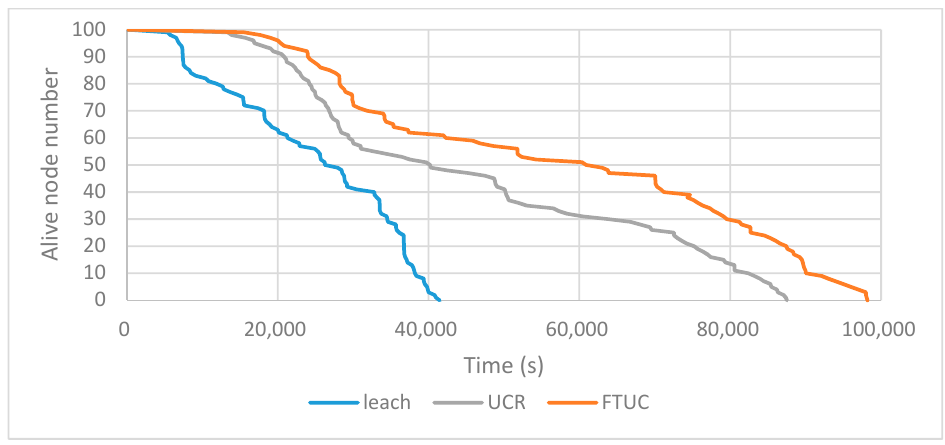
Figure 12. Network alive node numbers depending on time using LEACH, UCR, and FTUC. Table 3. Evaluation of lifetime LT-1 and LT2 for all three algorithms.